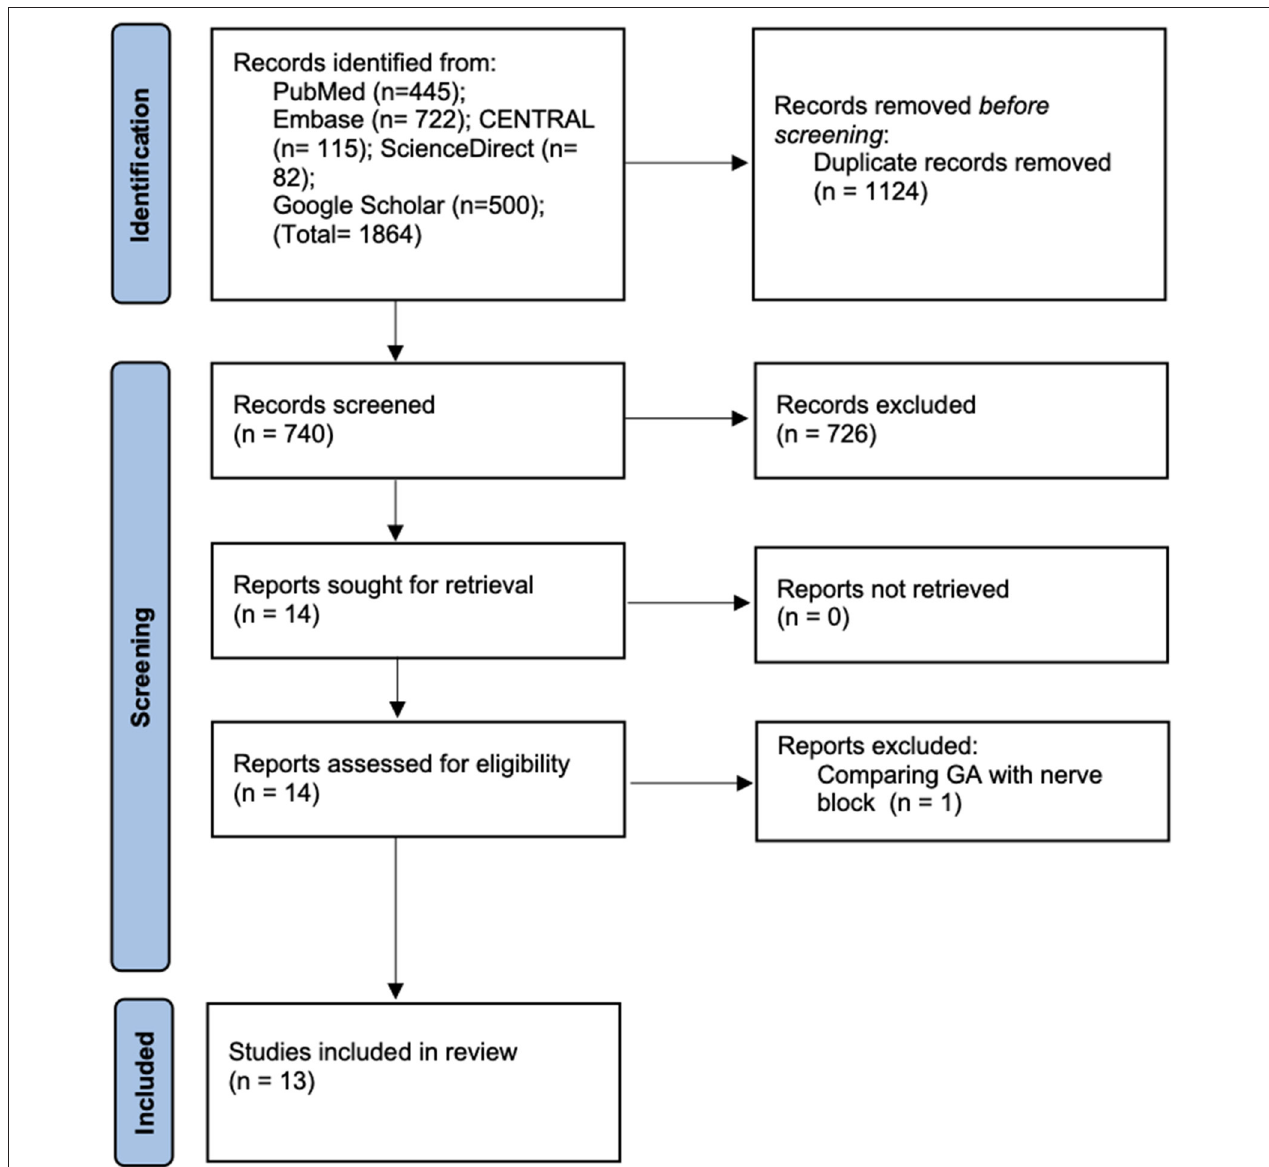
FIGURE 1 | Study flow